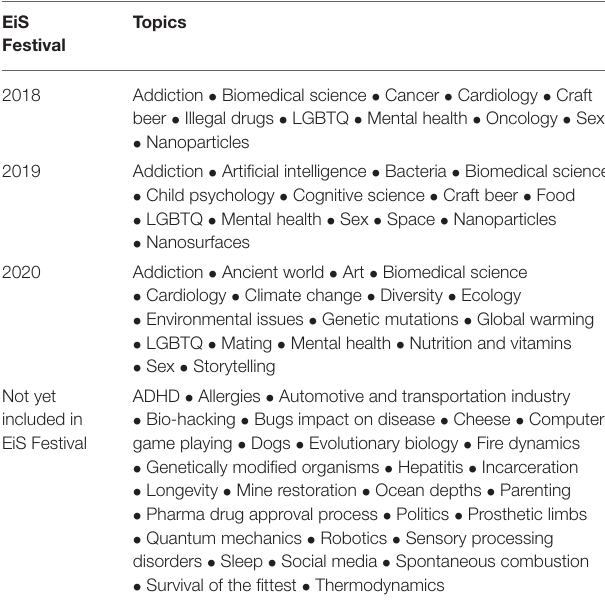
TABLE 1 | Overlap between audience recommendations from the 2019 EiS festival and the first three years of EiS festivals. EiS Festival